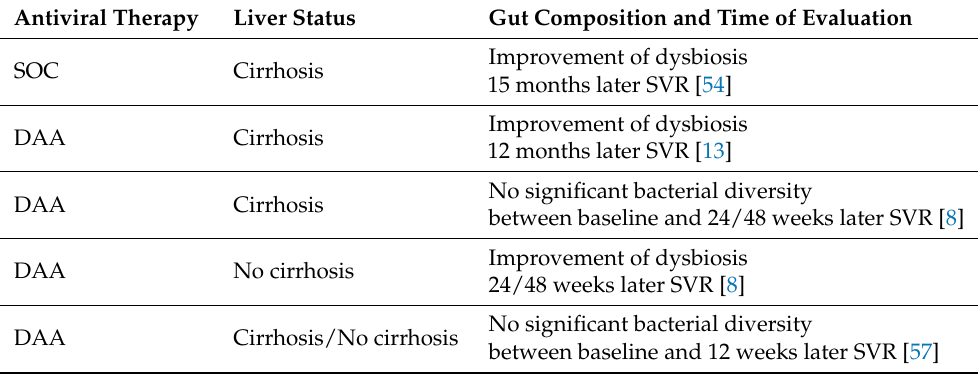
Table 1. Antiviral treatments and their effect on gut diversity of HCV infected patients. Antiviral Therapy Liver Status Gut Composition and Time of Evaluation Improvement of SOC Cirrhosis